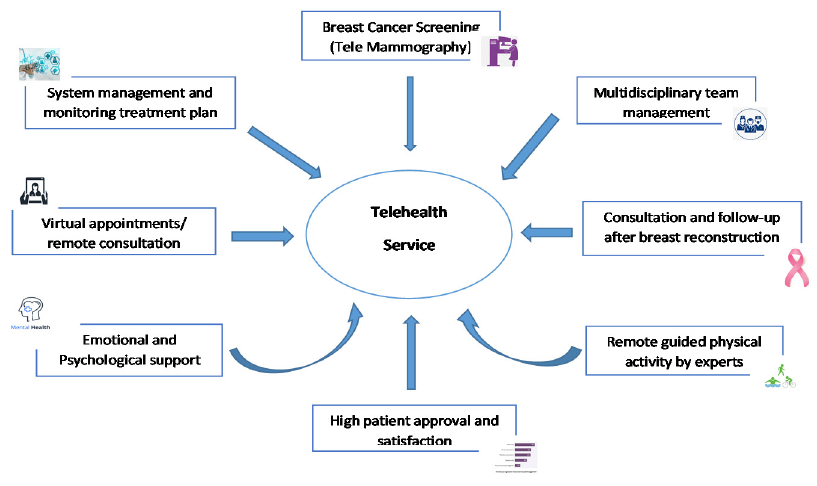
Figure 2. Schematic diagram of the utilization of telehealth to manage breast cancer patients.